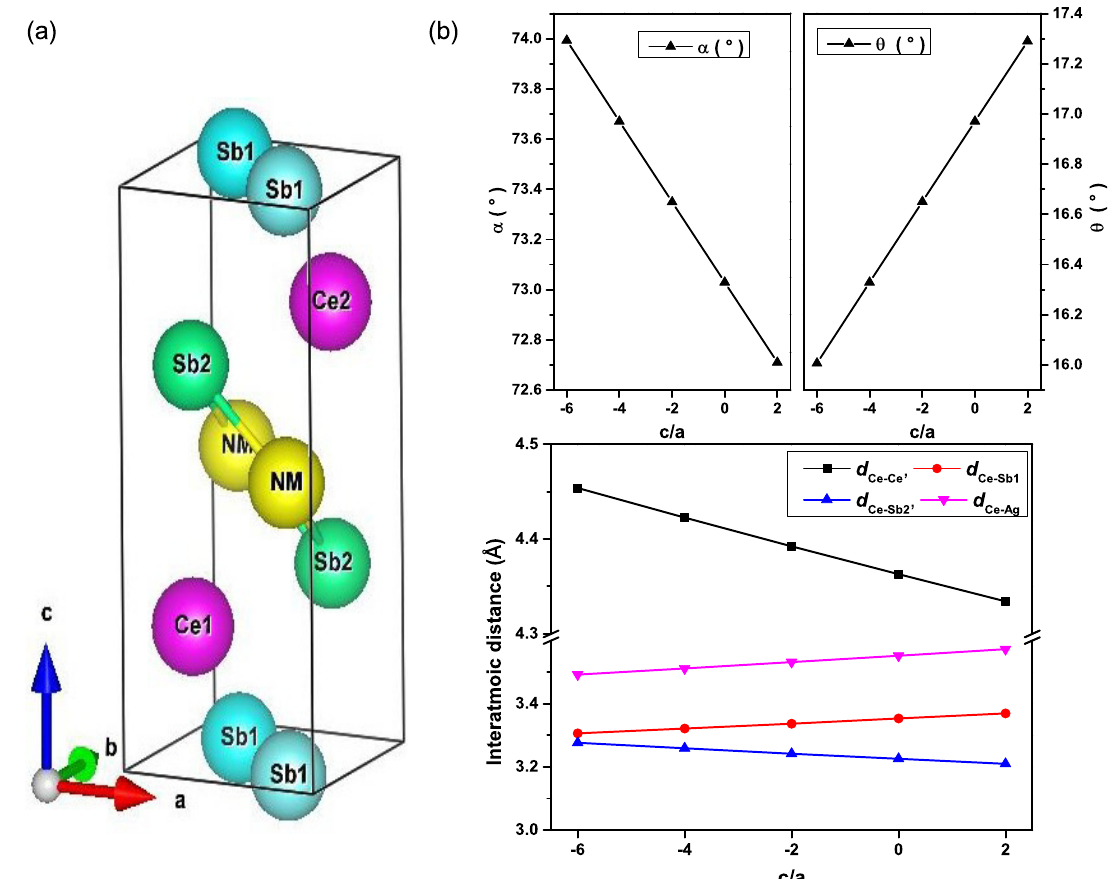
Figure 1. ( a ) Crystal structure of Ce NM Sb 2 and ( b ) variations of crystallographic data owing to the change of the c / a ratio at constant volume for the CeAgSb 2